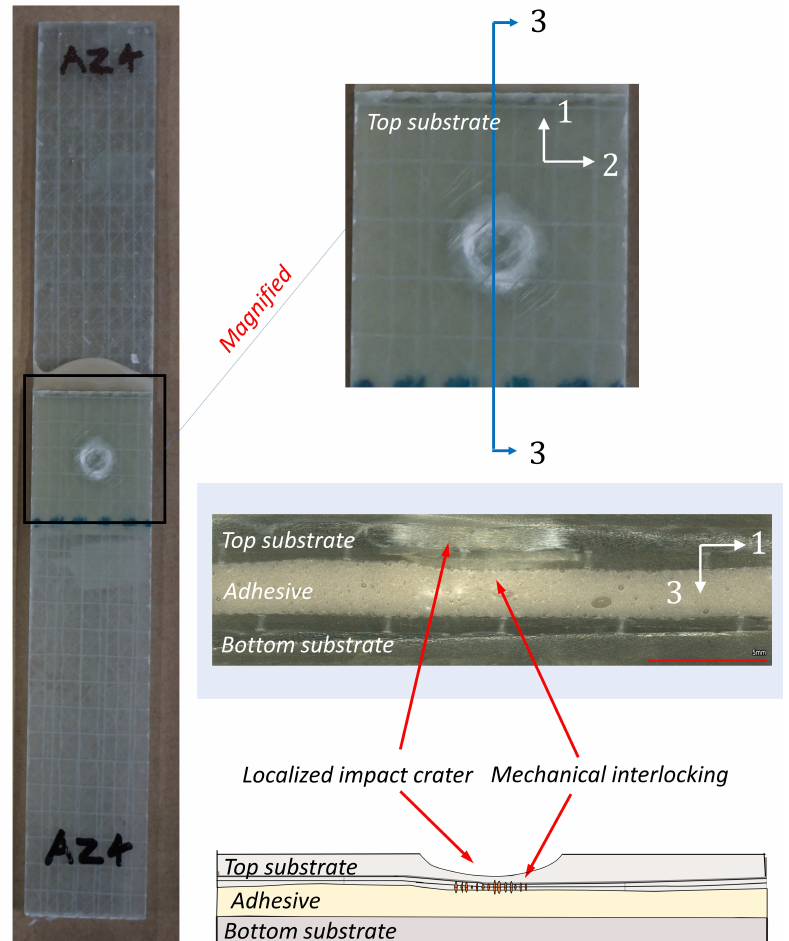
Figure 19. Cross-sectional scan of joint with bondline thickness of 0.6 mm subjected to 15 J of impact